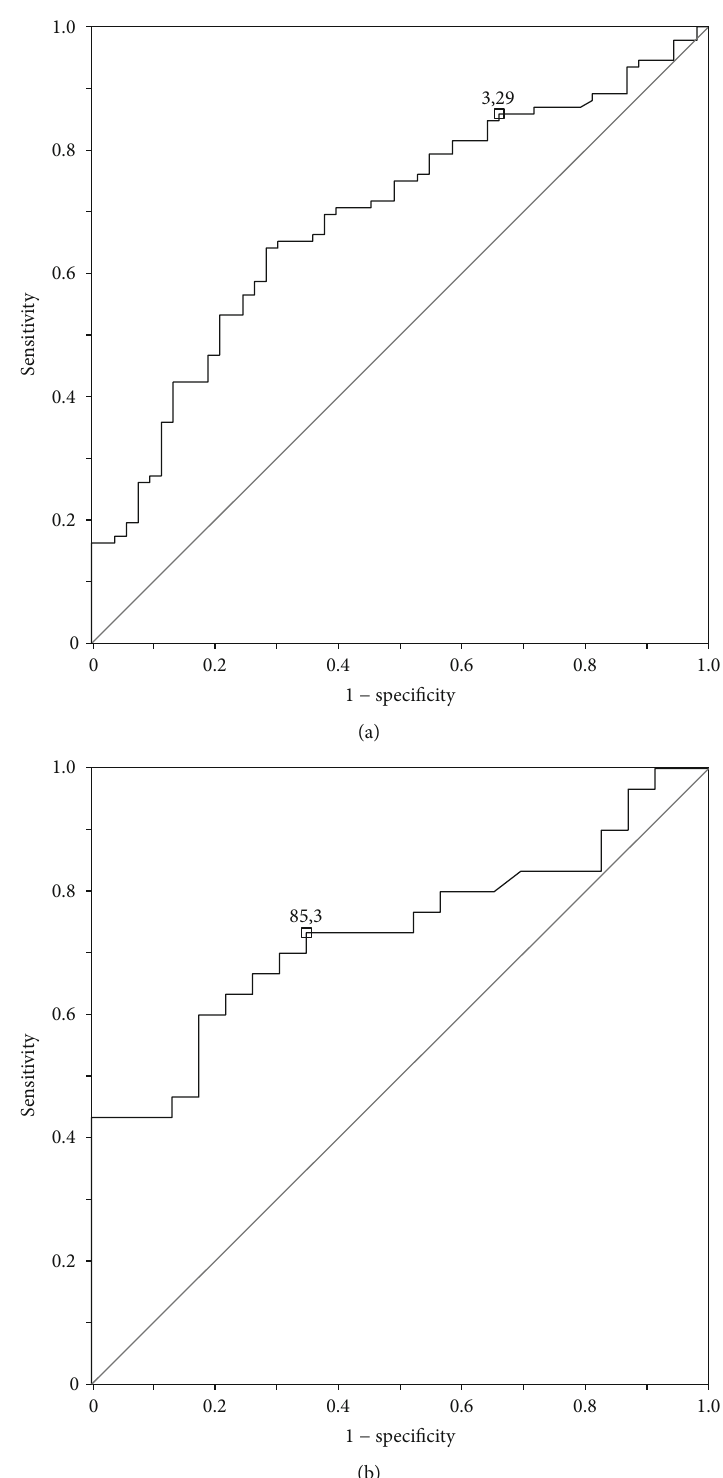
Figure 2: (a) ROC curve for age of diabetes diagnosis predisposing for CD (AUC 0.689 (95% CI 0.602, 0.776); p = 0 : 001 ). (b) ROC curve for TTG antibody titers predisposing for CD with villous atrophy (AUC 0.744 (95% CI 0.613, 0.876); p = 0 : 001